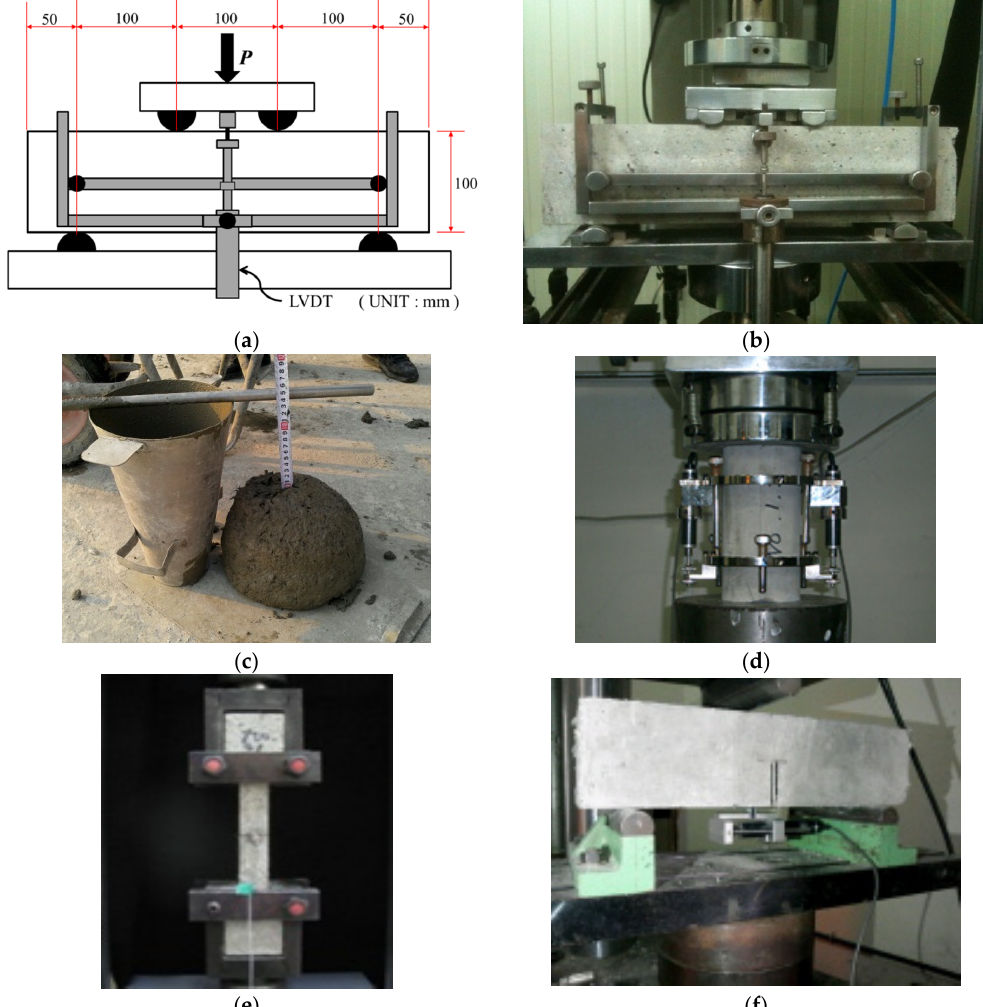
Figure 2. ( a ) Specimen geometry for bending test; ( b ) test set-up picture of bending test; ( c ) slump test; ( d ) compressive test; ( e ) direct tensile test; ( f ) fracture test.